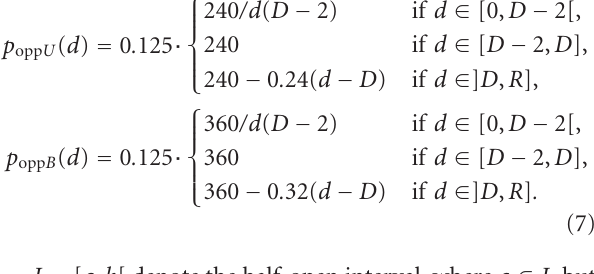
Figure 3: The potential p opponent ( a ) generated by opponent units as a function of the distance a .